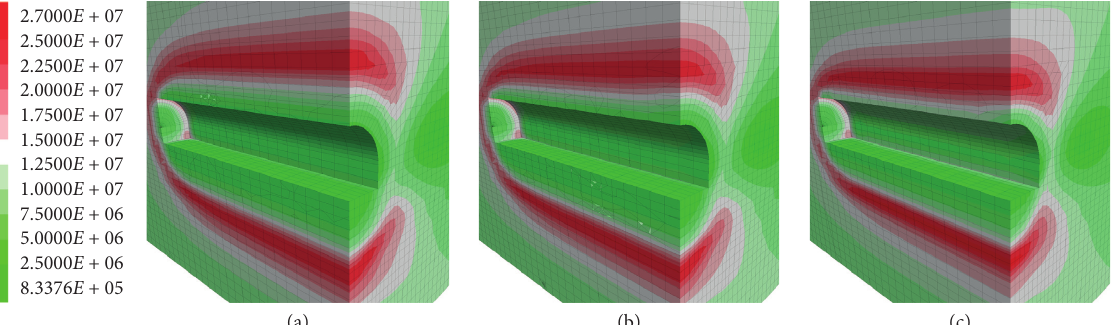
Figure 15: Max shear stress. (a) Unsupported. (b) Primary support. (c) Secondary support.